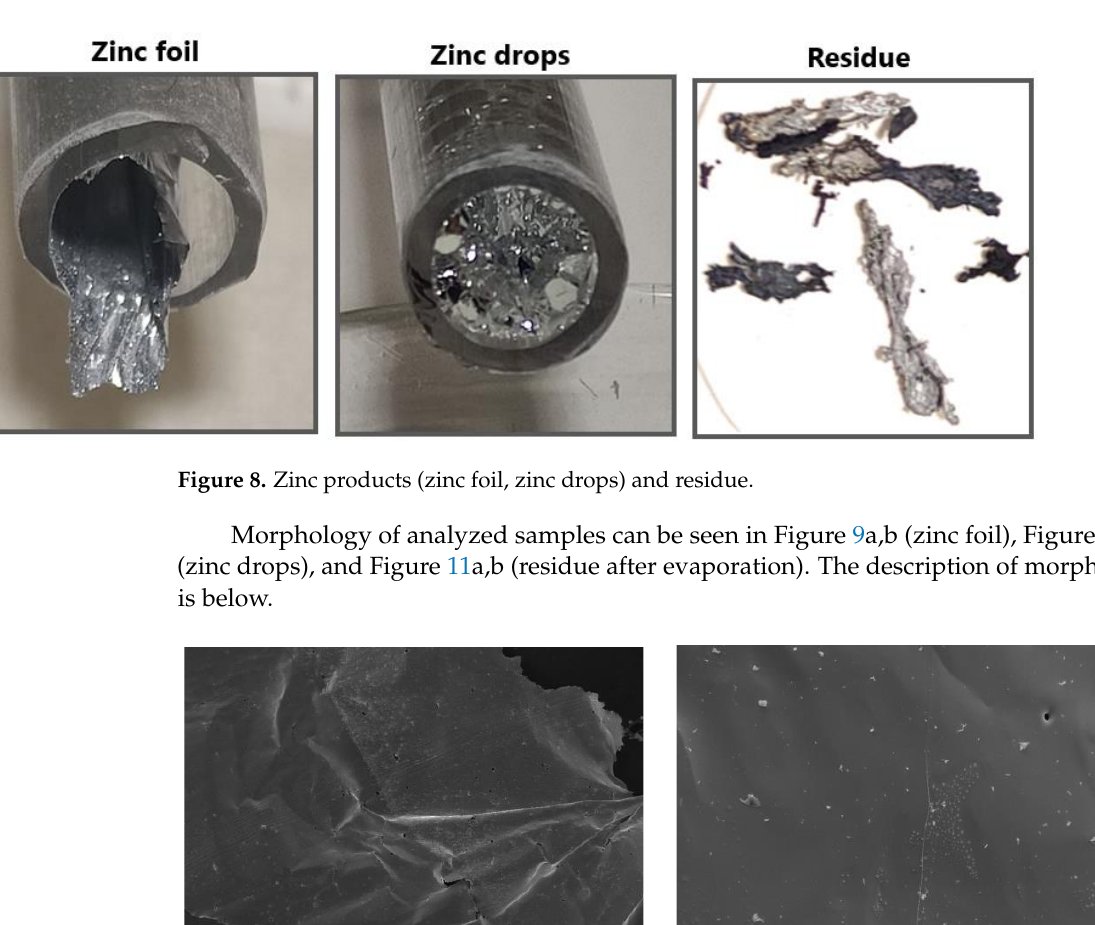
Figure 7. Quartz tube with a dose after evaporation process: zinc foil, zinc drops, and the residue.